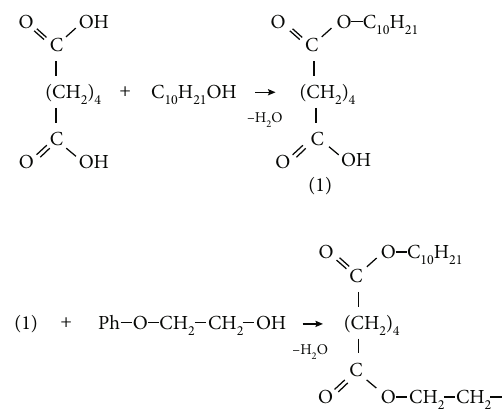
O+ Scheme 1: Synthesis of decyl phenoxyethyl adipate